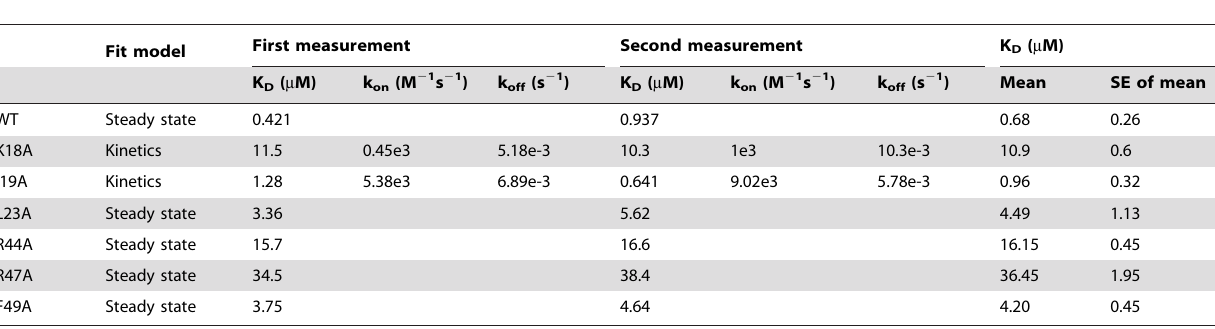
Table 2. Binding measurements of the SECRET domain with CX3CL1 wild type and its mutants by surface plasmon resonance (SPR)